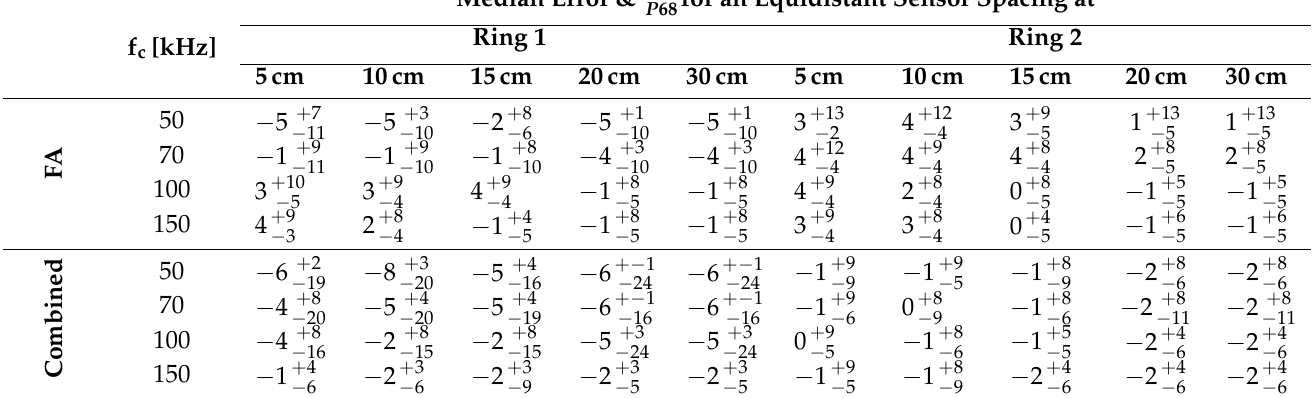
Table A3. Accuracy of the measured water levels.